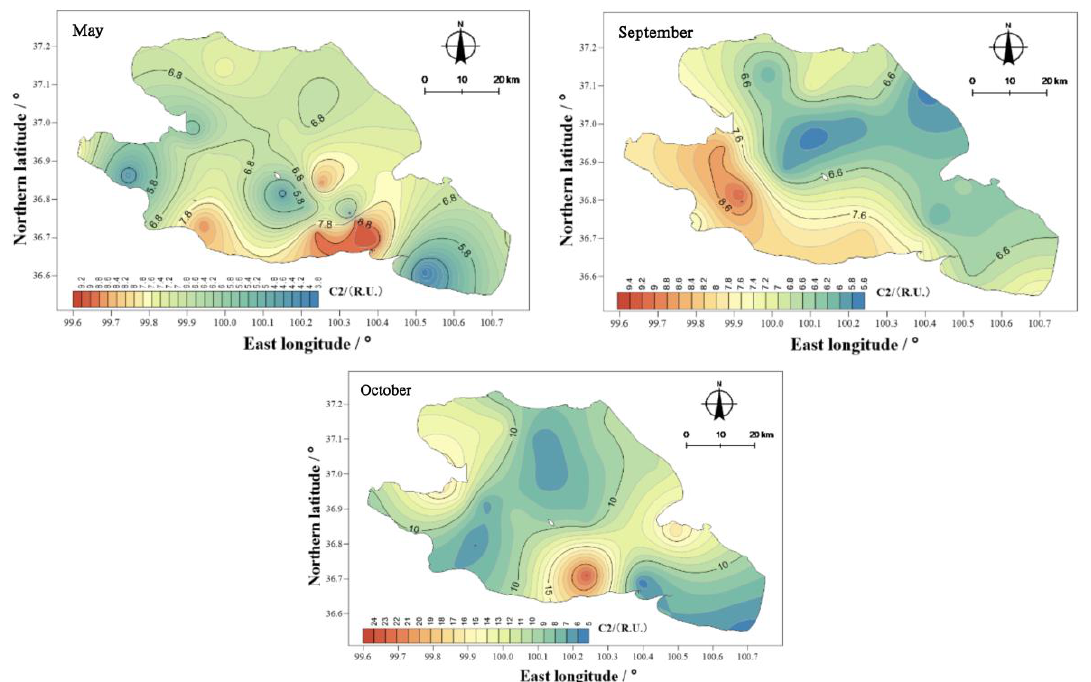
Figure 16. Spatial distribution characteristics of the fluorescence intensity of component C2 in Qinghai Lake in different seasons.